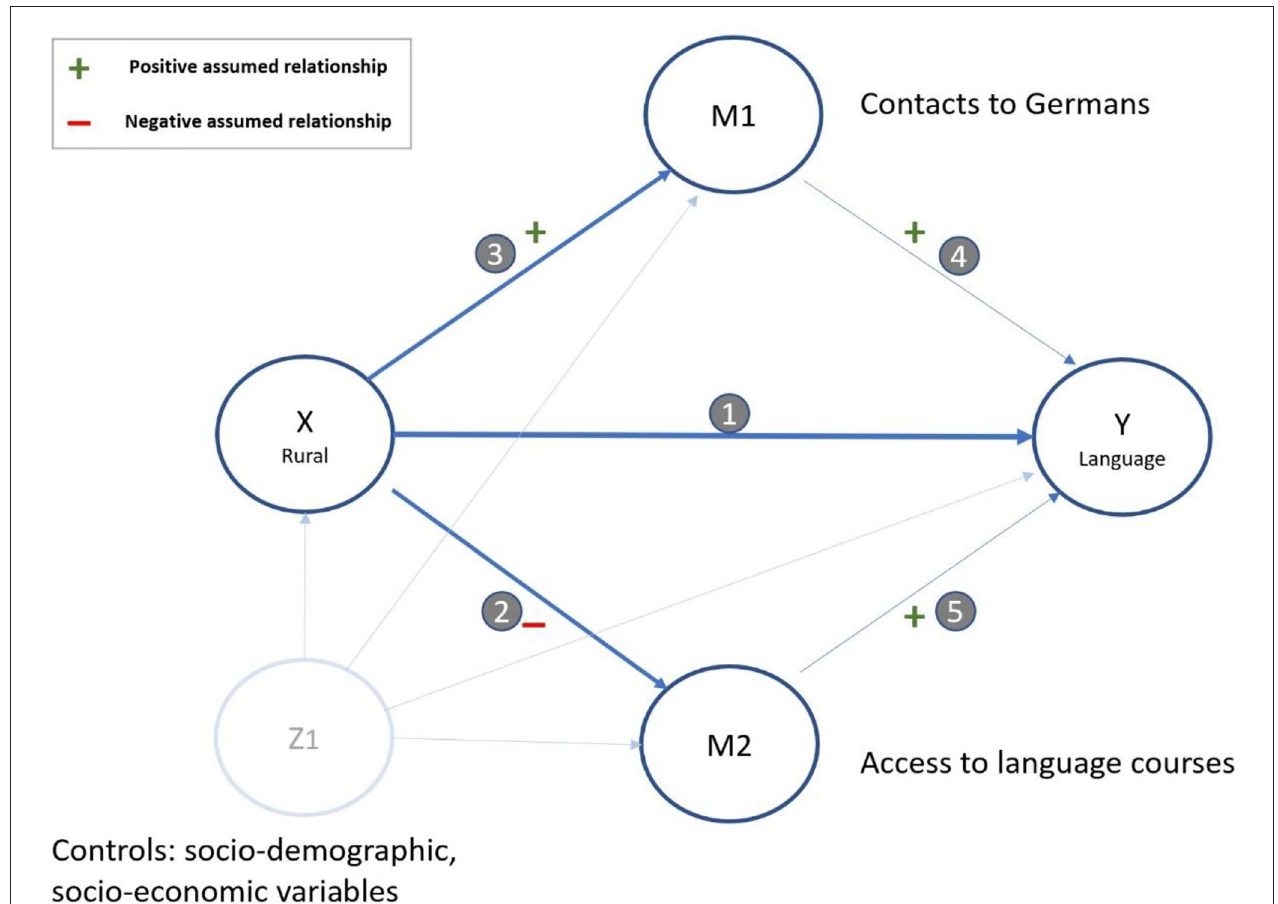
FIGURE 1 | Directed Acyclic Graph of the proposed causal